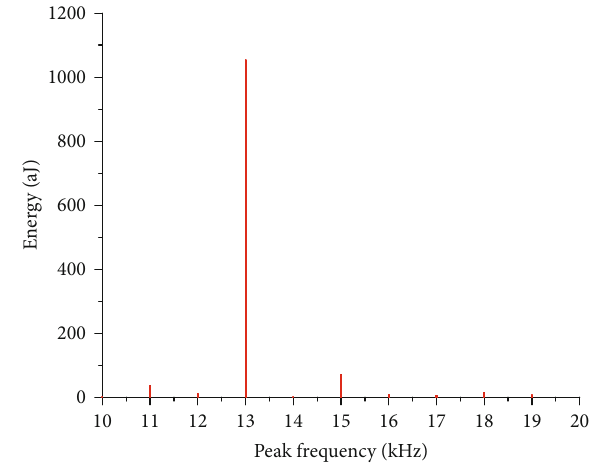
Figure 10: Distribution of AE energy with peak frequency (around 13 kHz). The range near 13 kHz is where the high acoustic emission energy is